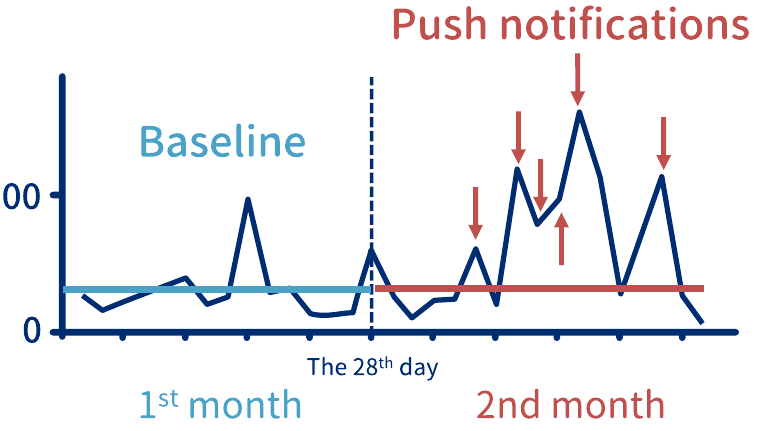
Figure 8. Smartphone apps can act as personalized reminder systems that intervene in excessive smartphone use. For example, the “Know Addiction” app automatically calculates users’ average smartphone usage time over one month and sets it as a personalized benchmark (baseline). If the usage exceeds the benchmark at any point during the following month (red arrows), a push notification is sent out to advise the user to reduce their usage and smartphone dependence.